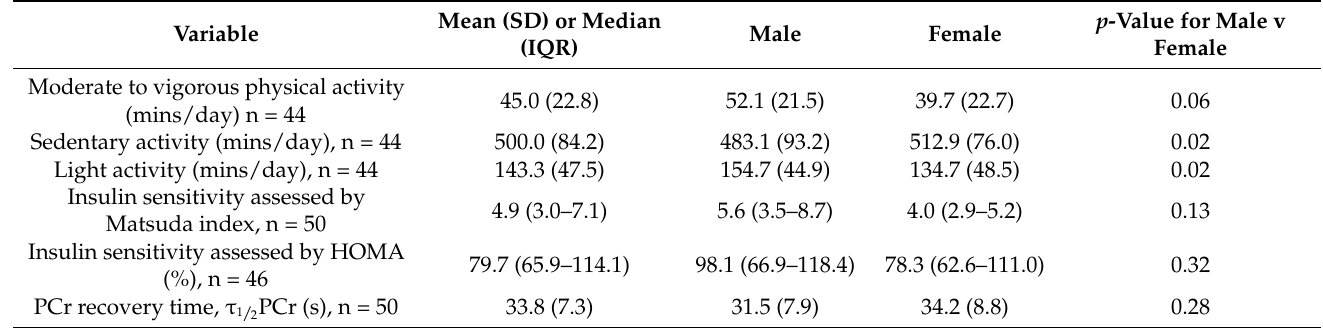
Table 2. Exercise and muscle function parameters assessed by accelerometery, oral glucose tolerance test and magnetic resonance spectroscopy. HOMA: Homeostatic model assessment, PCr: phosphocreatine.